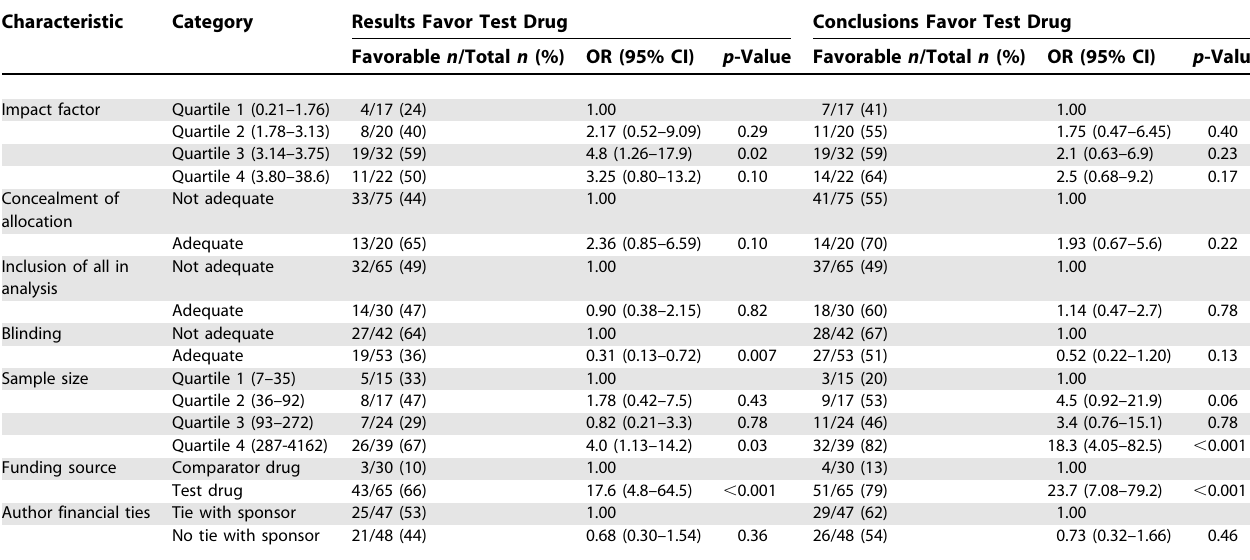
Table 4. Association between Characteristics of Industry-Funded Articles ( n ¼ 95) and Statistically Significant Results and Conclusions that Favor the Test Drug: Univariate Logistic Regression Characteristic